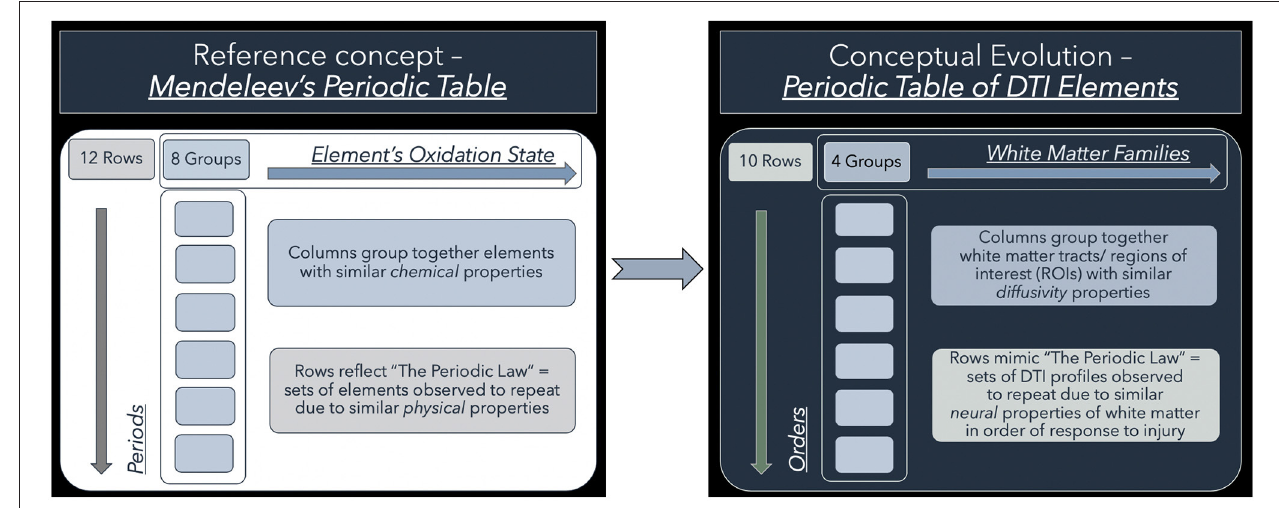
FIGURE 1 | Conceptual evolution from Mendeleev’s Periodic Table to the current work. The modern periodic table in chemistry is based on atomic number. This differs from Mendeleev’s original concept, which arranged the elements according to their similar chemical and physical properties. Mendeleev sorted the elements largely by atomic mass but where there were tensions in the order, he prioritized groups by their shared properties. Similarly, we have used shared “diffusivity” properties to group white matter tracts/ regions of interest (ROIs) into columns. This grouping into “White matter families” reflects their DTI neuroanatomy, changes in diffusivity profiles due to their differential risk from progressive ventriculomegaly. Mimicking the concept of periods, we have arranged sets of DTI profiles observed to repeat due to similar “neural” properties. These rows, which we have termed “ Orders ,” reflect commonly occurring DTI profiles seen in white matter in response to injury. Note that the Order from I to X here reflects a predicted trend from reversible to irreversible injury. This is arbitrarily defined and could equally work in reverse order as long as the sequence is maintained.